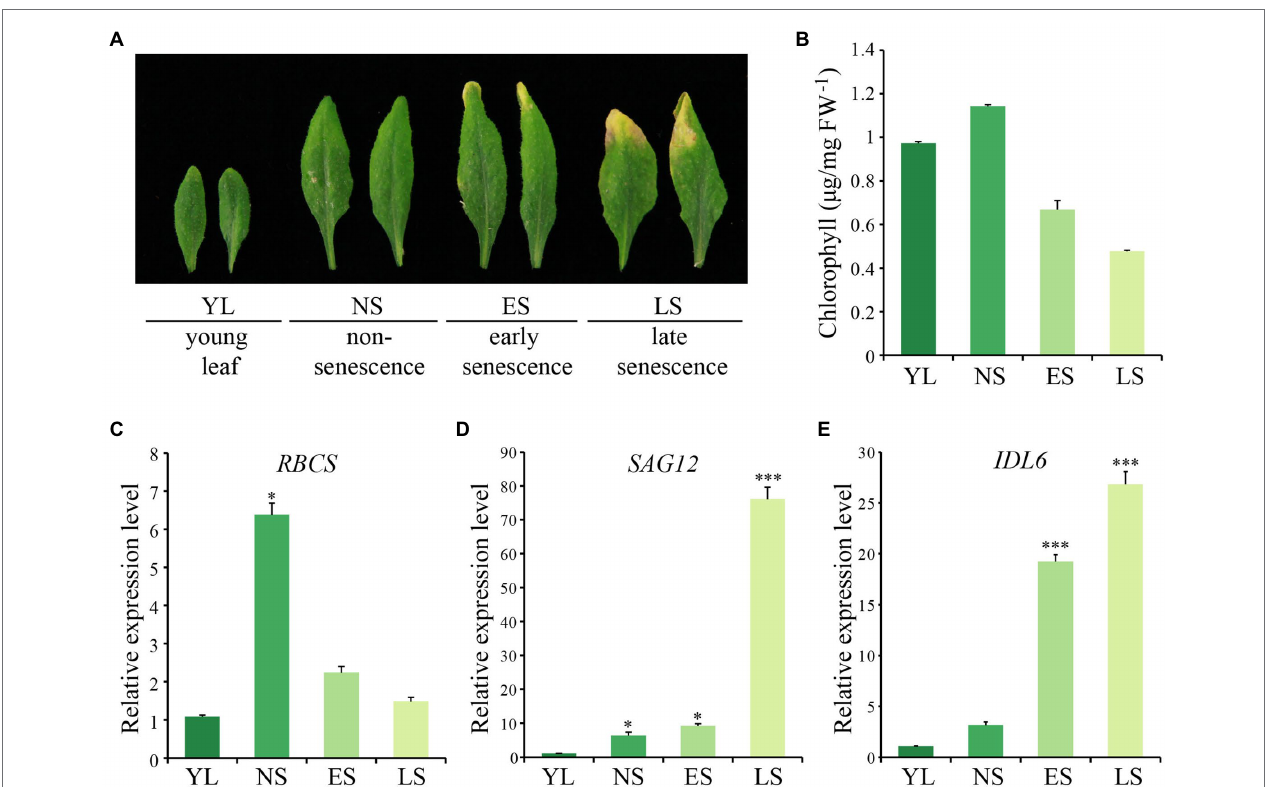
FIGURE 1 | The expression pattern of IDL6 during leaf senescence. (A) The Arabidopsis wild-type leaves at different developmental stages. YL: young leaf, NS: non-senescence leaf, ES: early senescence leaf, LS: late senescence leaf. (B) The chlorophyll contents of leaves at different developmental stages. (C–E) The transcript abundance of RBCS , SAG12 and IDL6 during leaf senescence. The data are means ± SD of three biological repeats. Significant difference compared with the YL was determined by Student’s t -test (* p < 0.05 and *** p <